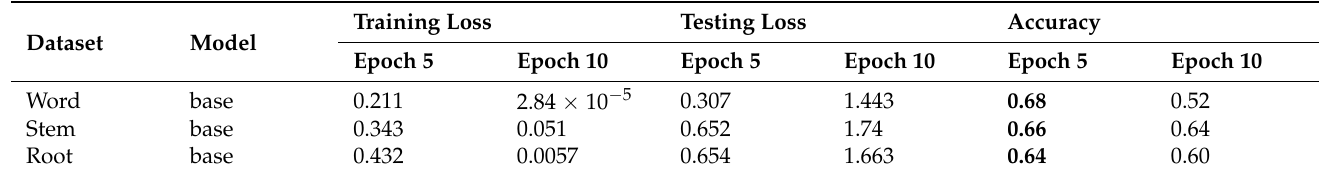
Table 5. Loss and accuracy of NSP models (best performance is in bold font).